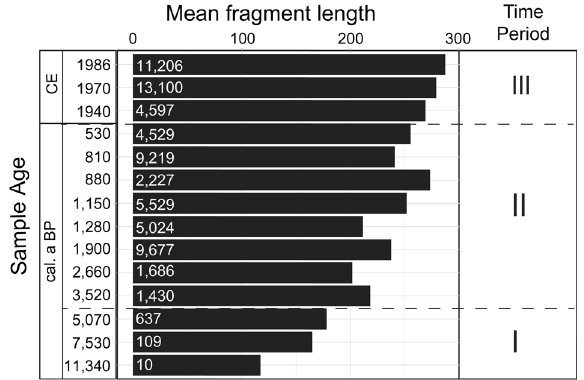
Fig. 6 Cyanobacteria ancient DNA reads from shotgun data. Bar plot showing cyanobacteria mean fragment length distribution from shotgun- analysed samples. Total cyanobacteria reads from each analysed depth is indicated in each bar. Dashed black lines demarcate the three signi fi cantly different temporal clusters identi fi ed by non-metric multidimensional scaling (see Fig.